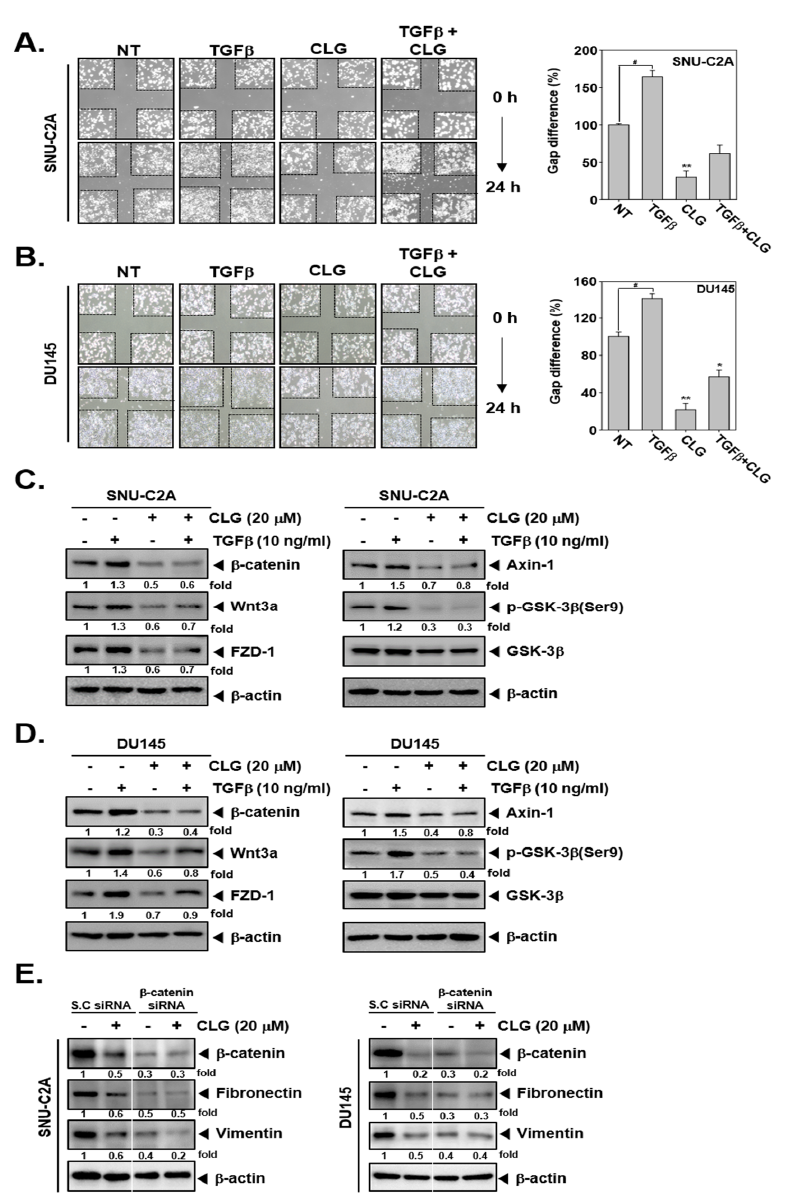
Figure 4. CLG down-regulated Wnt / β -catenin signaling cascades. SNU-C2A and DU145 cells were exposed to TGF β (10 ng / mL), CLG (20 µ M), or a combination for 24 h. ( A and B ) Cell migration was determined by wound healing assay. Data represent means ± SD. # p < 0.05 vs non-treated (NT) cells, * p < 0.05 vs TGF β treated cells, and ** p < 0.01 vs TGF β treated cells. ( C and D ) Western blotting for Wnt / β -catenin signaling cascades such as β -catenin, Wnt3a, FZD-1, Axin-1, p-GSK-3 β , and GSK-3 β . β -actin was used as a loading control. The results shown are representative of the three independent experiments. ( E ) SNU-C2A and DU145 cells were transfected with β -catenin siRNA or scrambled siRNA (100 nM) for 24 h. After that, cells were treated with CLG for 24 h and Western blotting for various antibodies was